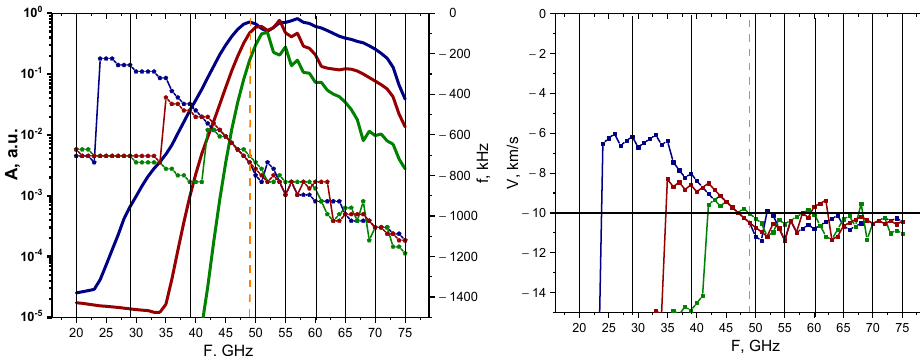
Figure 8. For the circular filament with an amplitude of 50%: ( left ) dependency of the DBS signal amplitude (bold lines with scale on the left) and frequency (lines with pentagon shapes with scale on the right) on the probing frequency; ( right ) dependency of the calculated velocity on the probing frequency. The navy-blue lines are the circular filament with a 3 cm diameter, the wine-red are that of 1.5 cm, and the olive-green are that of 0.5 cm. The black vertical lines indicate the probing frequencies available in Globus-M2, and the vertical orange dashed line indicates the position of the filament at cutoff of the 48 GHz probing wave. The horizontal line marks the set 10 km/s filament velocity.